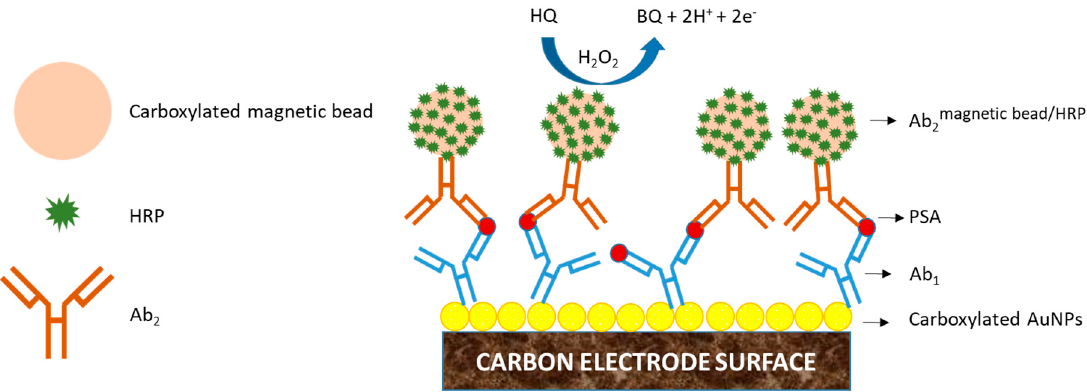
Figure 8. Diagram of the EI based on AuNPs electrode surfaces for the detection of PSA. Carboxylated AuNPs are electrostatically adsorbed onto PDDA modified carbon electrode surfaces. Ab 1 were covalently adsorbed onto AuNPs electrode surfaces via amide bond formation. PSA antigen is captured by Ab 1 . To improve sensitivity and signal amplification of the EI, Ab 2magnetic bead/HRP complex was employed. HQ was used as redox mediator and H 2 O 2 as enzyme substrate. Oxidation of HQ produce BQ, 2 mol of protons (H + ) and 2 mol of e − per mol of HQ involved in the electrochemical reaction. H 2 O 2 is reduced to water and oxygen [132].